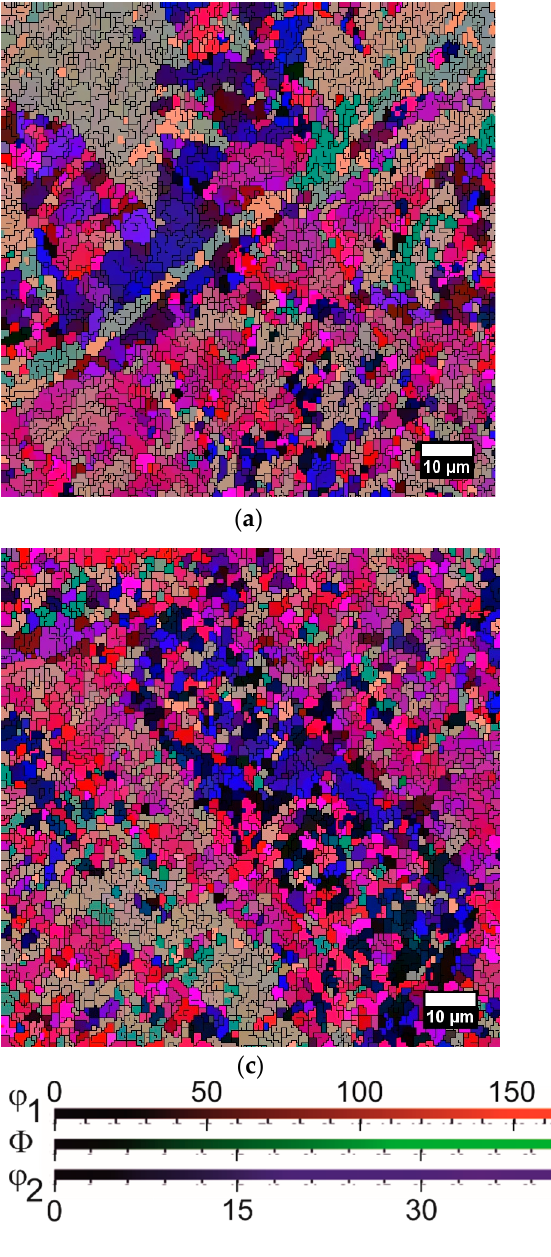
Figure 7. Distribution maps of the Euler angles φ 1 , Φ , and φ 2 of samples ( a,b ) C7-1 (near the C7 wire fracture region) and ( c,d ) C7-2 (far from the fracture region) in the center ( a,c ) and near the edge ( b,d ) of the cross-section. Euler angle legends and scales are shown in ( e ) with the same range of change in Φ and φ 2 .